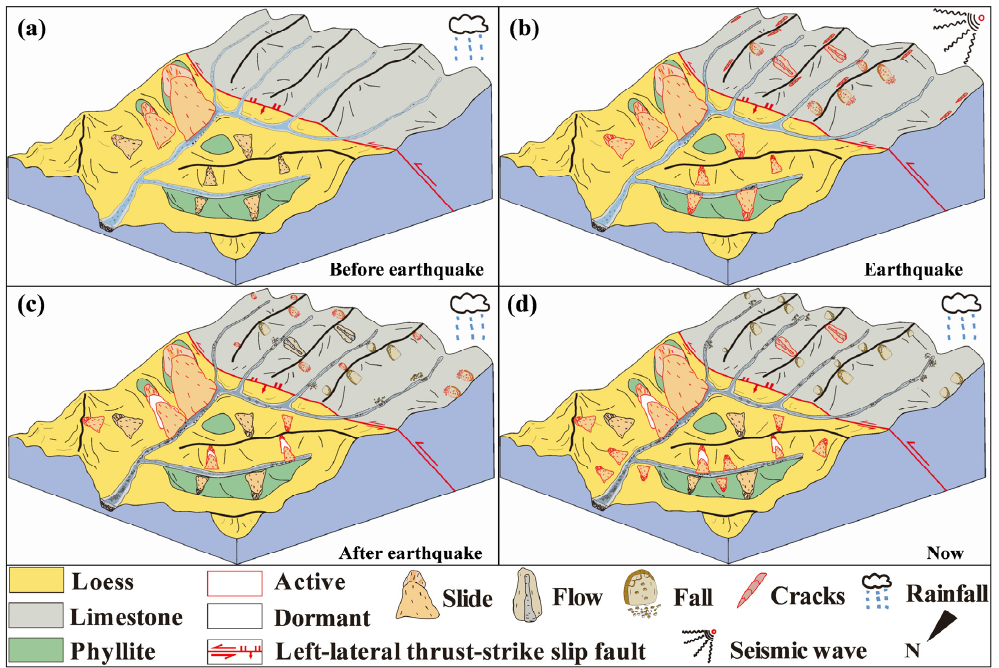
Figure 17. Conceptual model of landslide evolution in the study area. ( a ) Before earthquake; ( b ) during the earthquake; ( c ) after earthquake; ( d ) now.